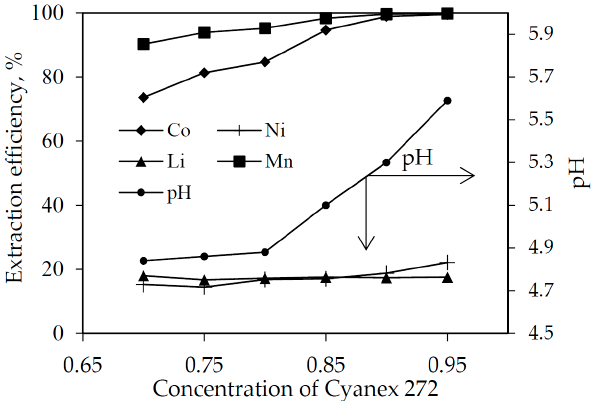
Figure 2. Effect of concentration of 50% saponified Cyanex 272 on metal extraction and pH.